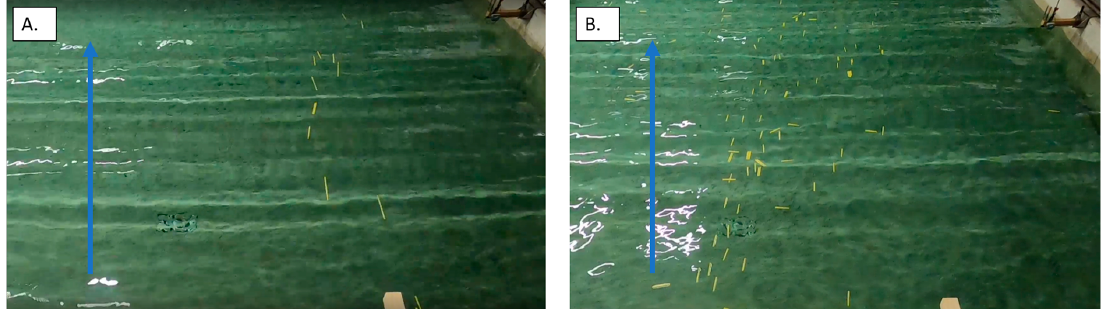
Figure 8. A still from footage taken from a GoPro mounted on the Ground Radar frame. ( A ) Shows the yellow 24 cm straws moving perpendicular to the waves on top of the water. ( B ) Shows the yellow 6 cm straws moving perpendicular, parallel, and diagonal with the waves. Blue arrow indicates the direction of the moving wave.